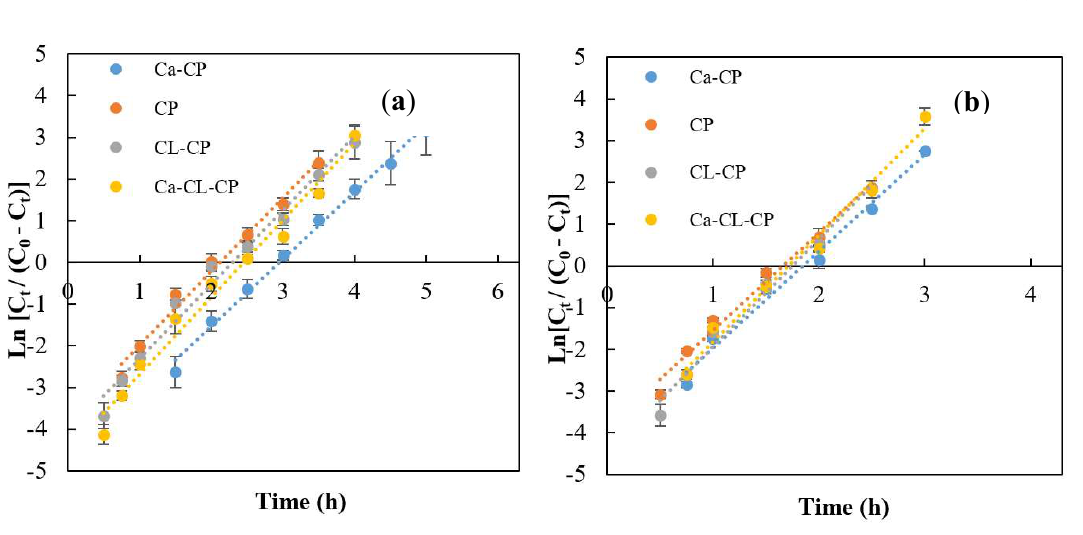
Figure 6. Linear plots of Yoon–Nelson model for various adsorbents at 25 °C: ( a ) pH 4.5, and ( b ) pH 6.5 at a fixed initial sulfate concentration (1000 mg / L), flow rate (3 mL / min), and a fixed-bed depth of 200 mm.